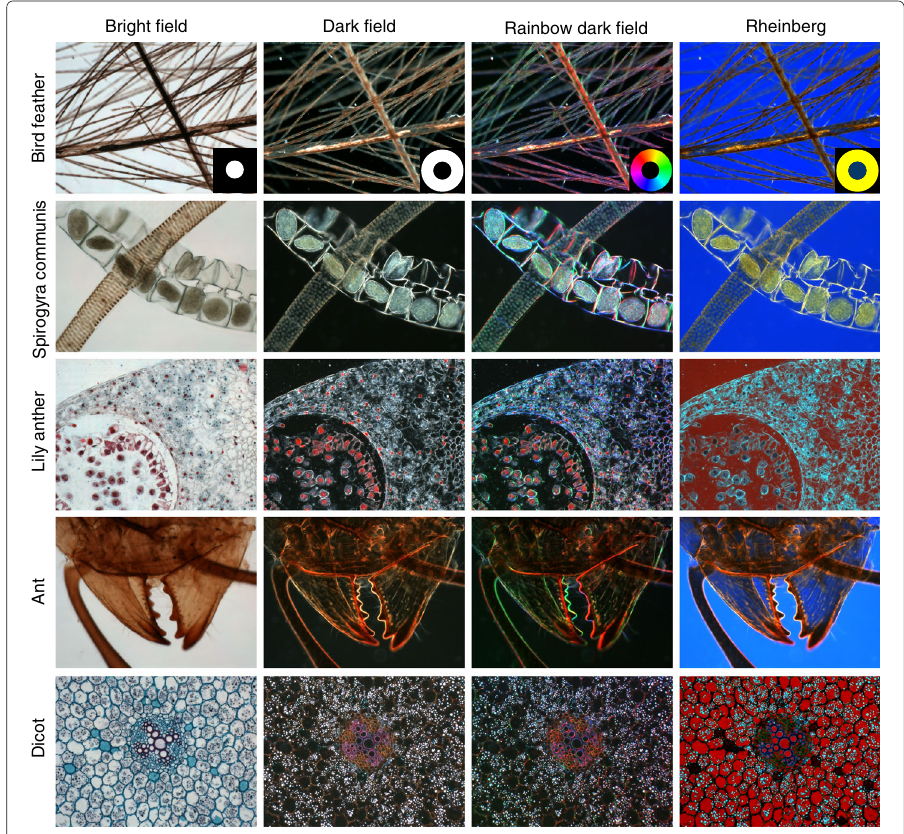
Fig. 21 The muli-contrast visualization results of bird feather, spirogyra communis, lily anther, ant, and dicot under bright field, dark field, rainbow dark field and Rheinberg optical staining imaging